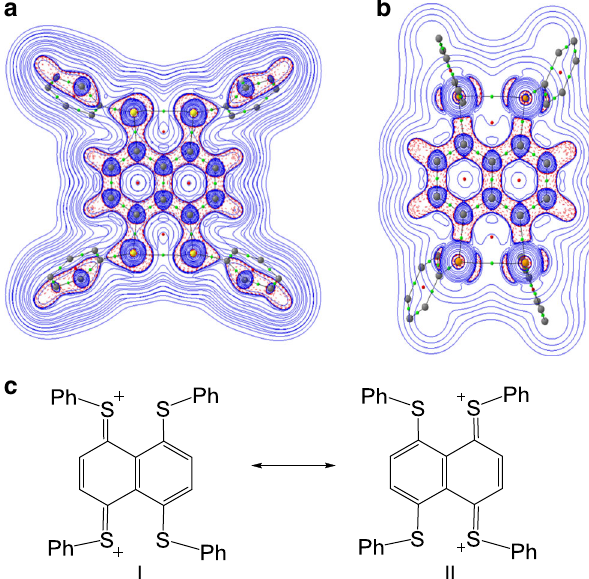
Fig. 6 Plots of the Laplacian ∇ 2 ρ (r) and resonance structures. Plots of the Laplacian ∇ 2 ρ (r) for 1 2 + ( a ) and 2 2 + ( b ). Red dashed lines indicate areas of charge concentration ( ∇ 2 ρ (r) < 0), while solid blue lines show areas of charge depletion ( ∇ 2 ρ (r) > 0). The solid lines connecting the atomic nuclei are the bond paths. Green dots are bond critical points and red dots are ring critical points. c Resonance structures of 1 2 +